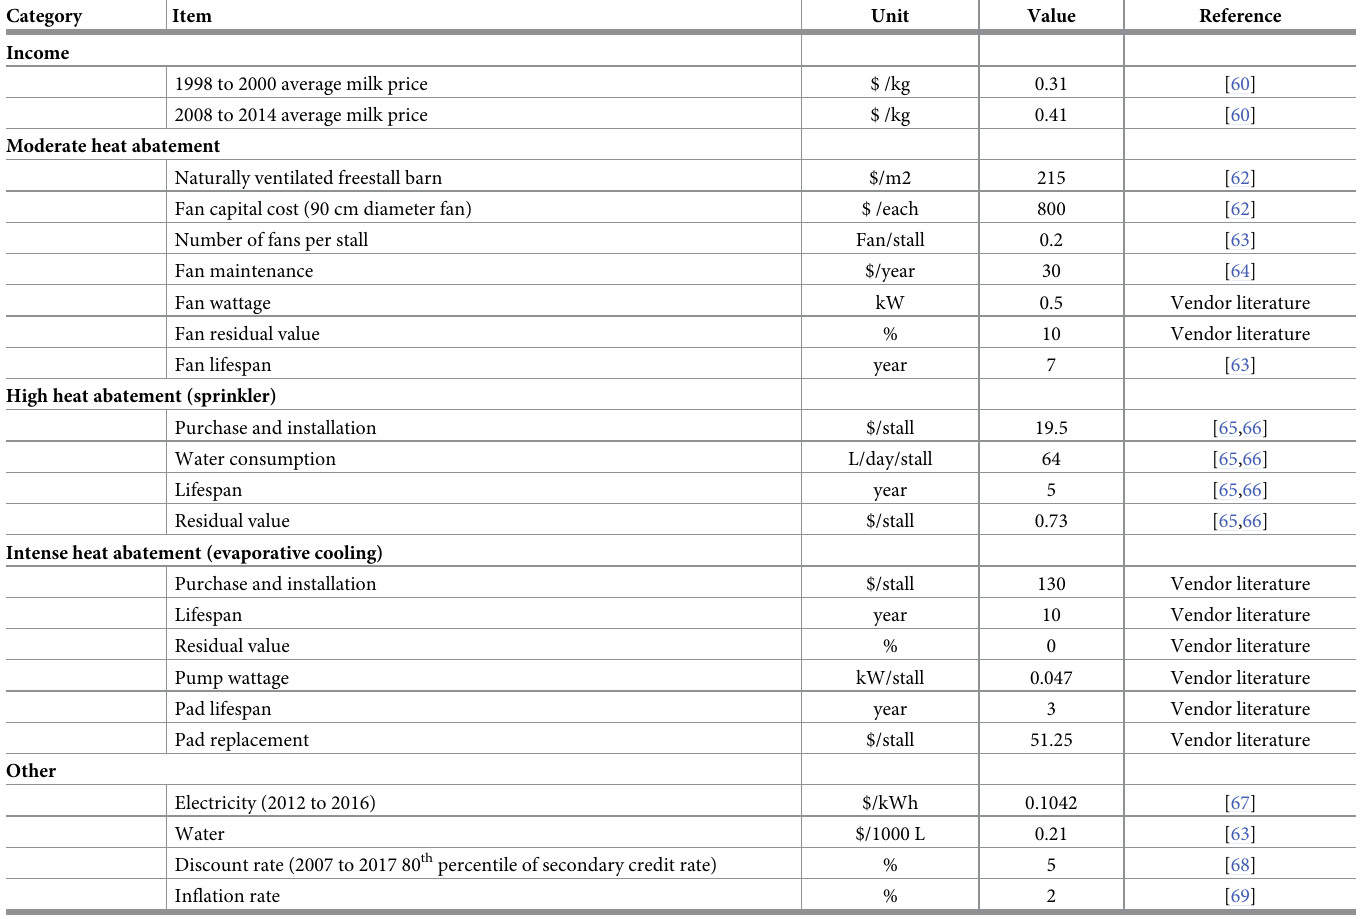
Table 1. Mean milk prices and heat abatement cost estimation